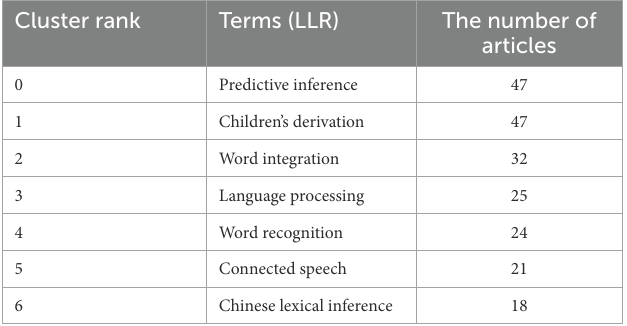
TABLE 2 Summary of clusters #0 to cluster #6. Cluster